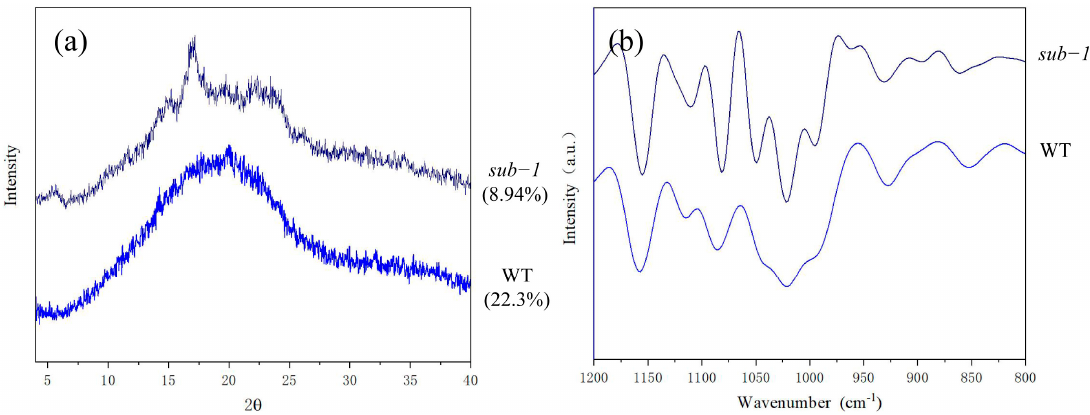
Figure 3. X − ray diffraction patterns ( a ) and fourier transform infrared spectroscopy ( b ) of the two duckweed